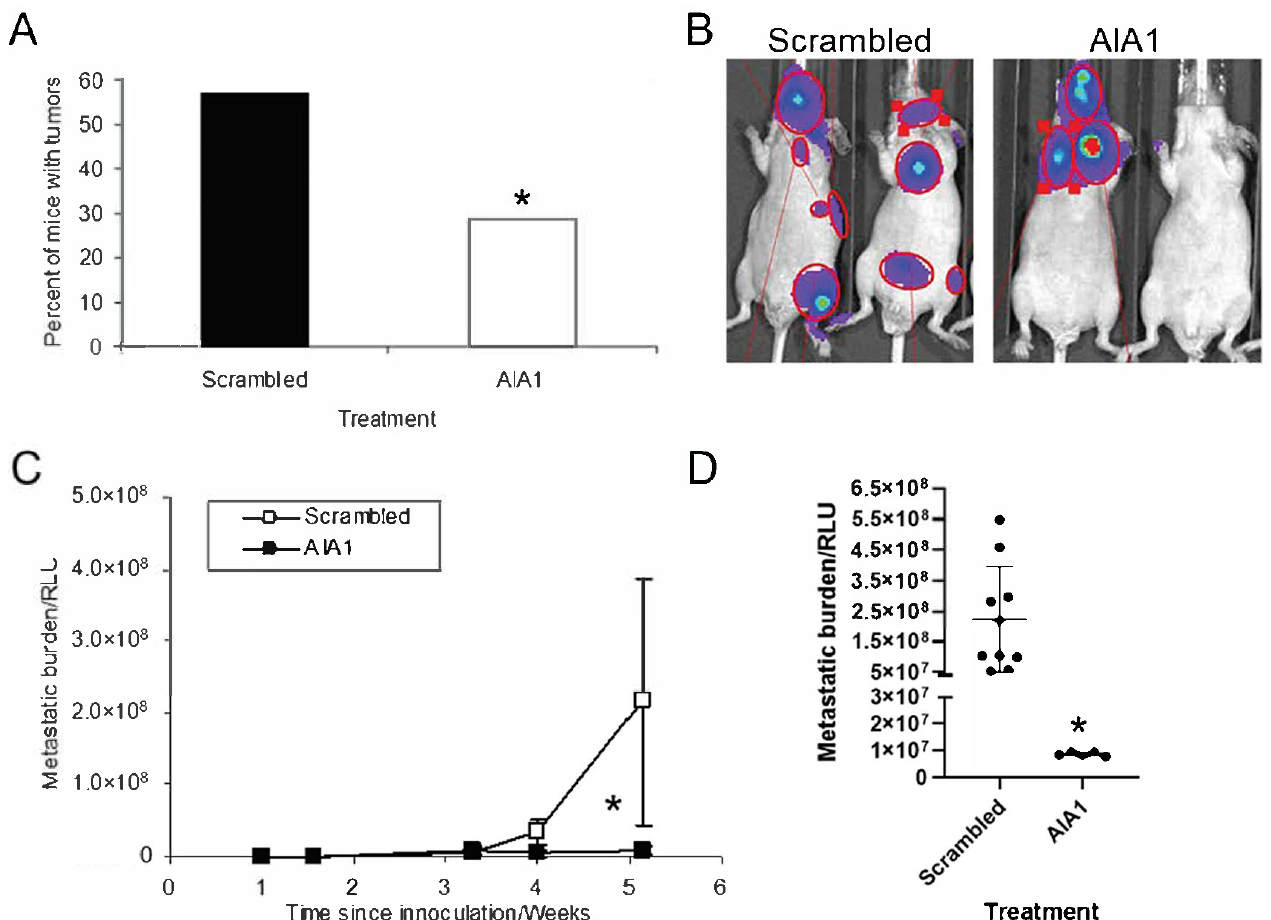
Figure 5. Tumor burden in nude mice following intracardiac injection of PC-3 Luc 5-2 inv cells. 2.5 × 10 5 cells of PC-3 Luc in 0.1 mL were injected into the left ventricle of the heart ( n = 20 mice per treatment group) and treated with scrambled control or AIA1 aptamer daily by I.P. injection for seven days. Mice were subjected to bioluminescence imaging (BLI) weekly to determine tumor burden. ( A ) Percent of mice that developed metastases . * p < 0.05. ( B ) Demonstration of BLI. Circled lit areas indicate tumor growth and were used as regions of interest for the calculation of tumor burden. ( C ) Tumor burden over time-based on BLI. Results are reported as mean ± SD. * p < 0.05. ( D ) Tumor burden at day 36 post-tumor inoculation based on BLI. Individual animals’ RLU expression are indicated. (Note, one Scrambled and one AIA-treated mouse died on days 8 and 10, respectively, due to peritonitis and were not counted in the tumor burden results). Results are reported as mean ± SD. * p < 0.05.